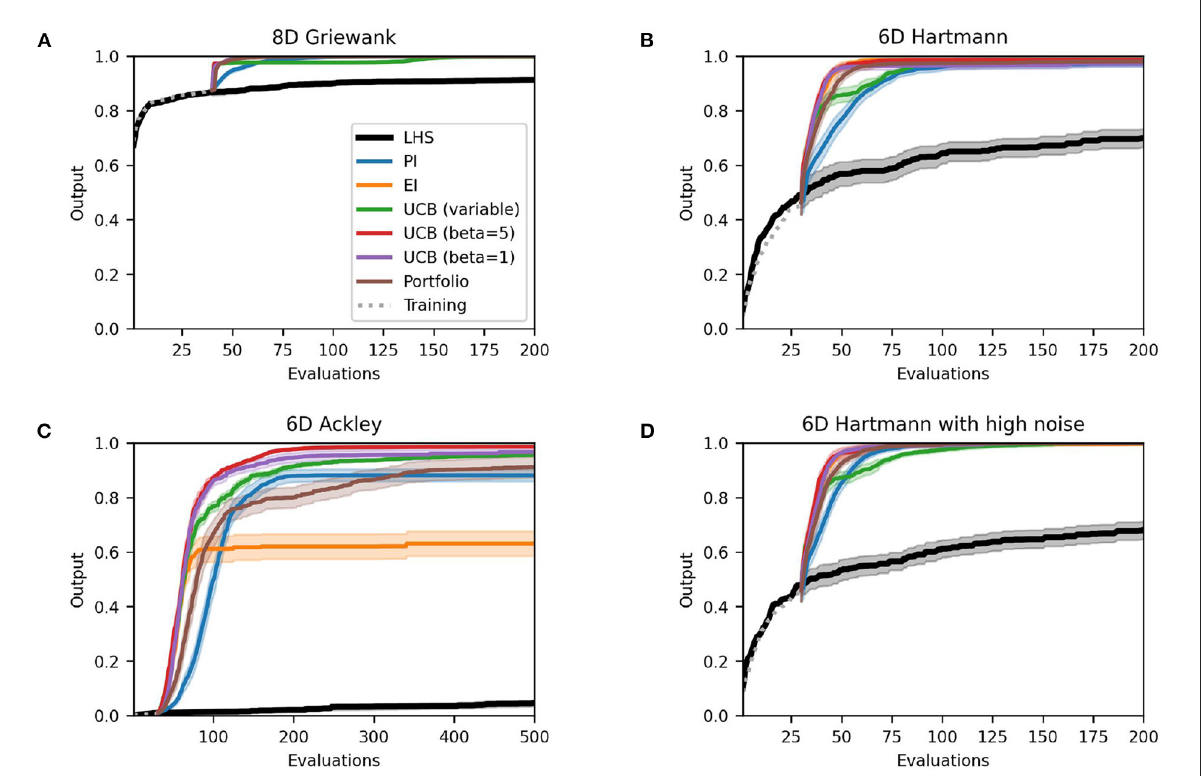
FIGURE2 Performance plots for analytical single-point acquisition functions with five initial starting points per input dimension. Solid lines represent the mean over the 50 runs while the shaded area represents the 95% confidence